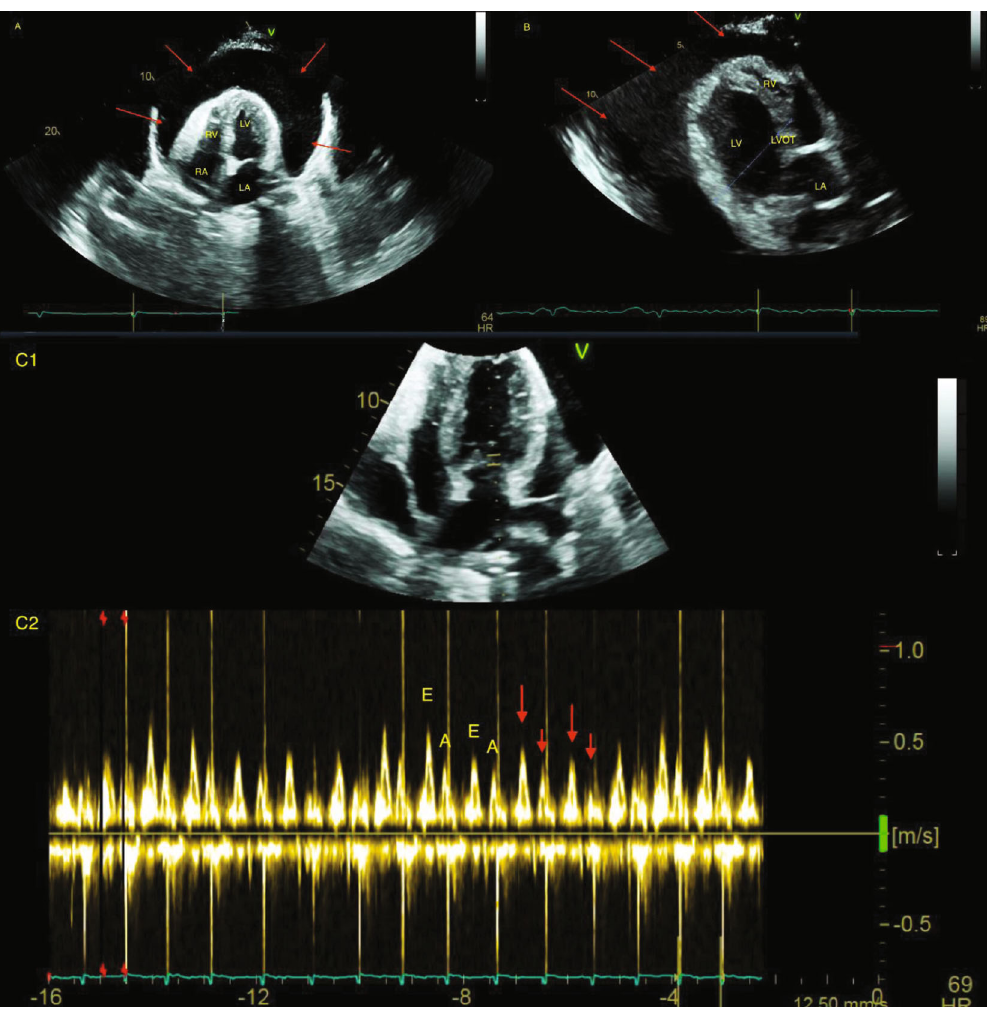
Figure 3: Transthoracic echocardiogram on day 0. Very large pericardial e ff usion with a swinging heart (red arrows in (a) and (b)), RV diastolic collapse, and marked mitral in fl ow respiratory variation (red arrows in (c)) consistent with signi fi cant tamponade. (a) Apical 4- chamber view; (b) parasternal long-axis view; (c) apical 4-chamber view showing the position of the Doppler pulse wave vector to obtain the mitral in fl ow waveform; (d) mitral in fl ow